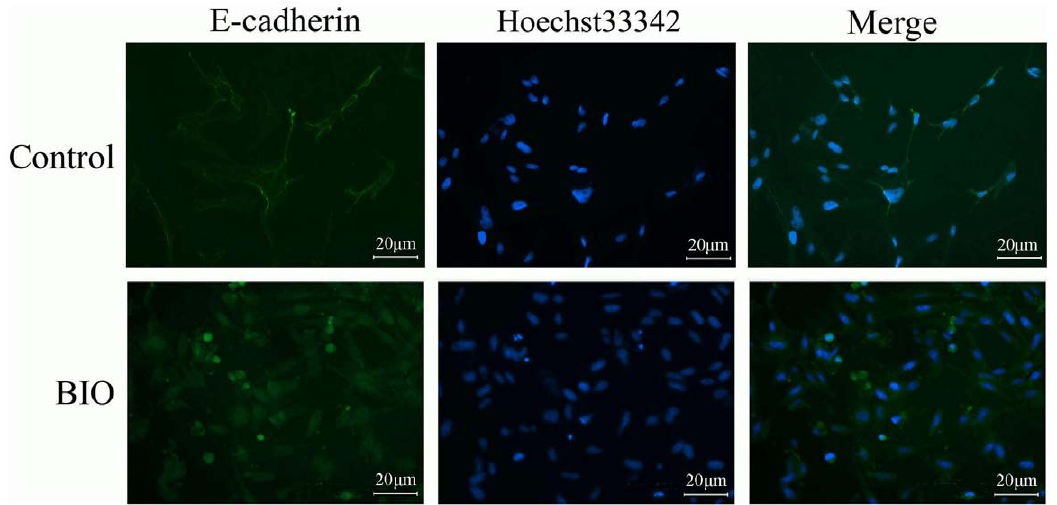
Figure 4. E-cadherin staining analysis. E-cadherin showed a bright membrane staining in untreated (Control) and translocated into cytoplasm in BIO-treated iPMSCs. Bar=20 m m.